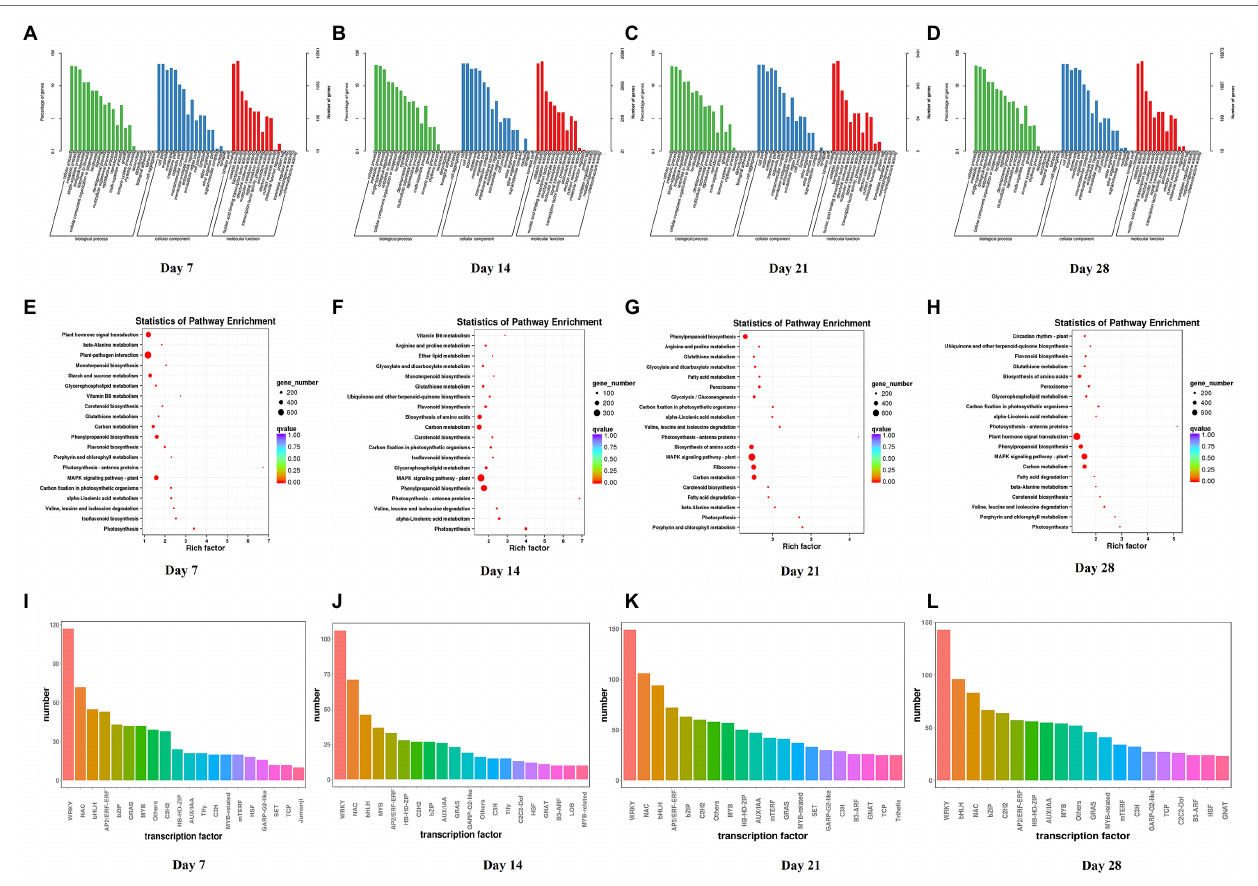
FIGURE 4 | GO classification, KEGG enrichment analysis and transcription factor prediction of DEGs between Dryland inoculated with Verticillium alfalfae (HD + V) and control group (HD) on days 7, 14, 21, and 28. (A–D) GO classification of DEGs on days 7, 14, 21, and 28. (E–H) KEGG enrichment analysis of DEGs on days 7, 14, 21, and 28. (I–L) Transcription factor prediction of DEGs on days 7, 14, 21, and 28. n = 3 per group for each time